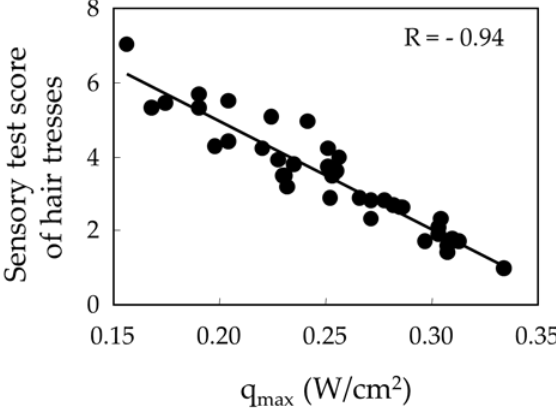
Figure 11. The relationship between the sensory test score and the q max of hair. The correlation coefficient (R) was calculated by regression analysis.